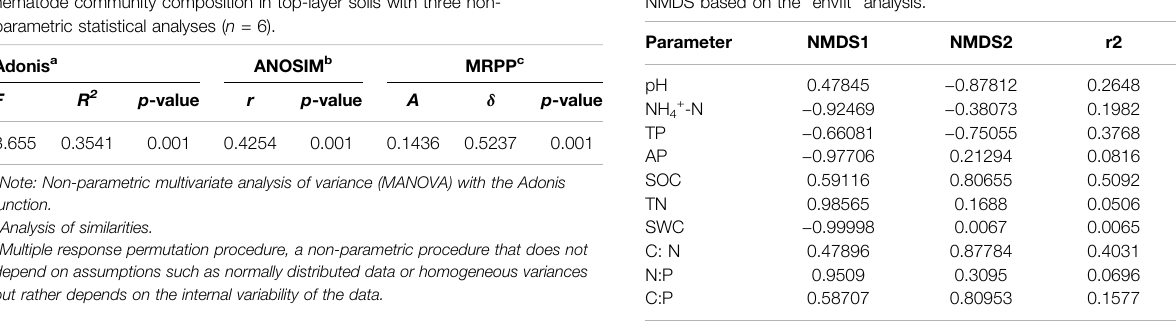
test: χ 2 = 10.85, df = 3, and p = 0.01; Figure 5B ), structure footprint (Kruskal – Wallis test: χ 2 = 18.21, df = 3, and p = 0.0004; Figure 5C ), herbivore (plant-feeding nematode) footprint (Kruskal – Wallis test: χ 2 = 18.73, df = 3, and p = 0.0003; Figure 5D ), bacterivore footprint (Kruskal – Wallis test: χ 2 = 9.61, df = 3, and p = 0.02; Figure 5E ), fungivore footprint (Kruskal – Wallis test: χ 2 = 10.85, df = 3, and p = 0.01; Figure 5F ), and omnivore footprint (Kruskal – Wallis test: χ 2 = 18.35, df = 3, and p = 0.0004; Figure 5G ). Further analysis suggested that nematode metabolic footprints were correlated to the SOC content, TP content, C/N and C/P of soils ( Supplementary Figure S4 ).